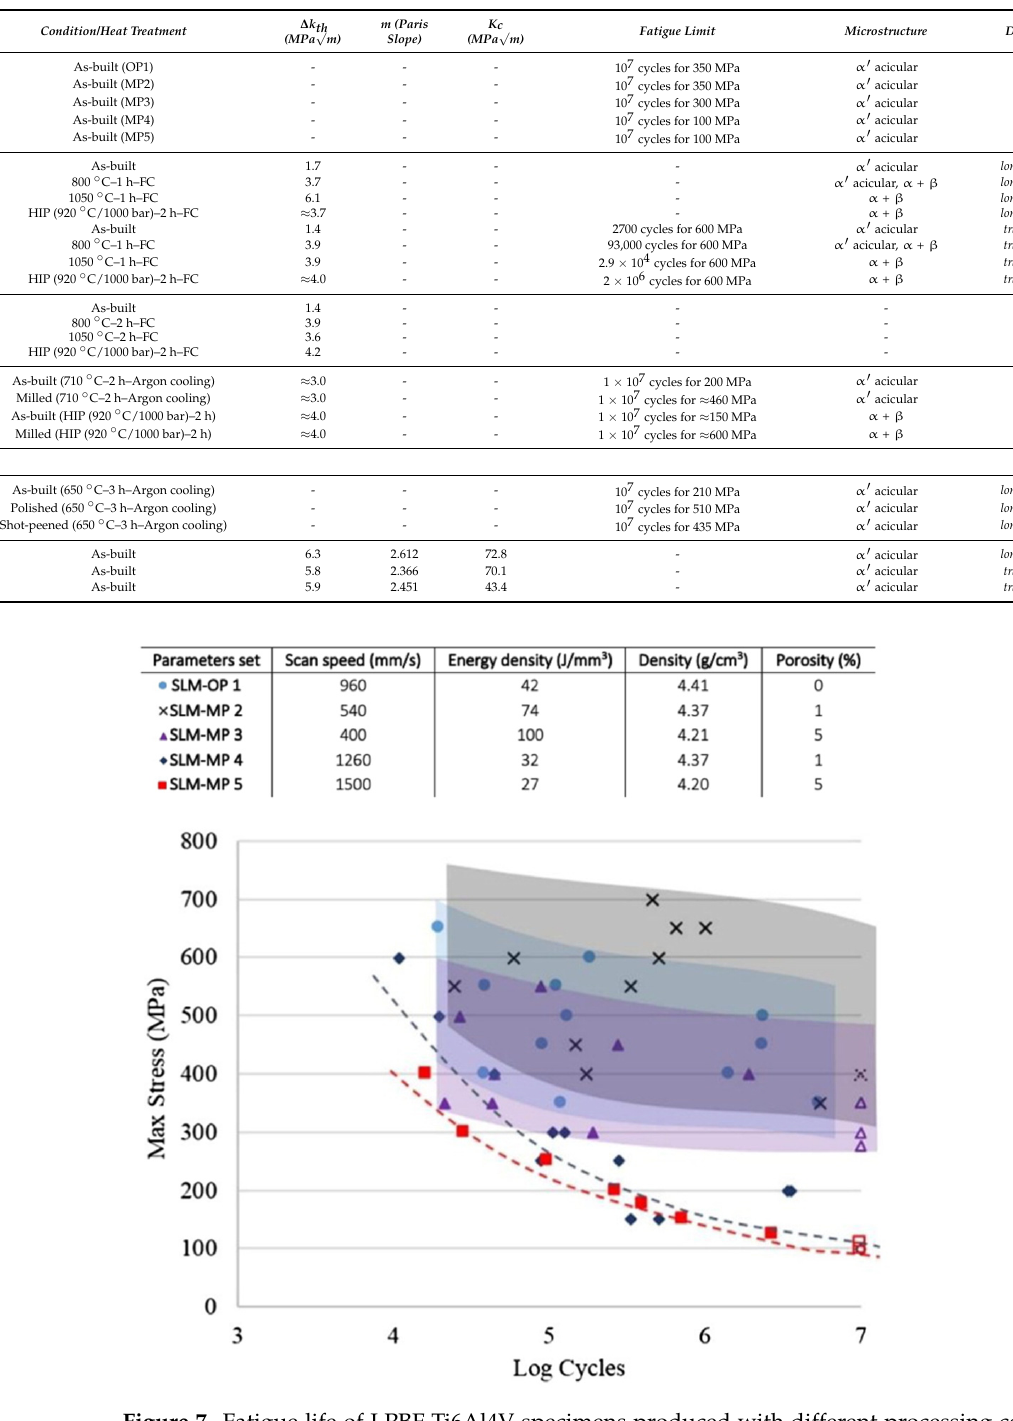
Figure 7. Fatigue life of LPBF Ti6Al4V specimens produced with different processing conditions (adapted with permission from [69]. Copyright 2015 Elsevier).